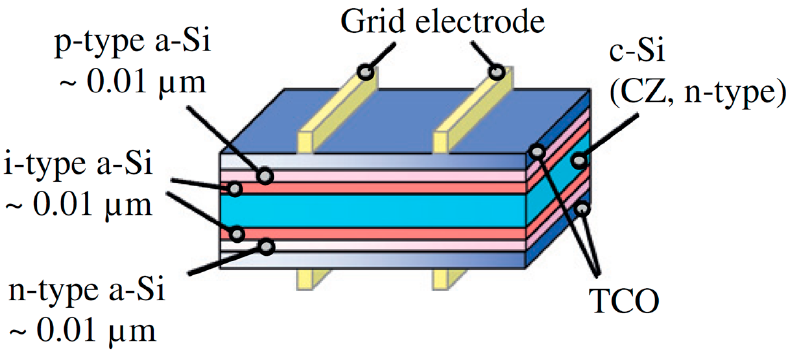
Figure 5. Structure of the HIT cell. Reprinted/adapted with permission from Ref. [40]. 2011, Else-